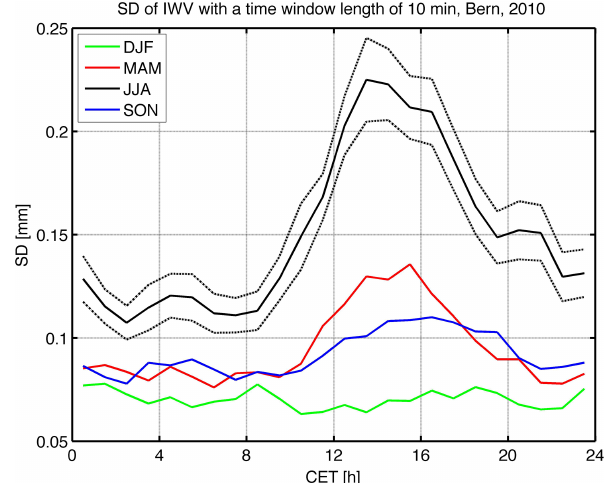
Figure 4. Spectra of IWV fluctuations observed at Bern for the four seasons of the year 2010. The green, red, black, and blue lines are obtained by a moving standard deviation (SD) with a variable time window length for winter, spring, summer, and autumn respectively. The magenta line shows the inclination for A ∼ T 0 . 5 p (or power P ∼ f − 1 ) where f is the frequency and T p is the period.